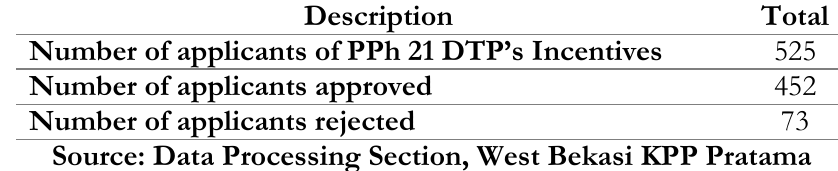
Number of Taxpayers Received Tax Incentives of PPh 21